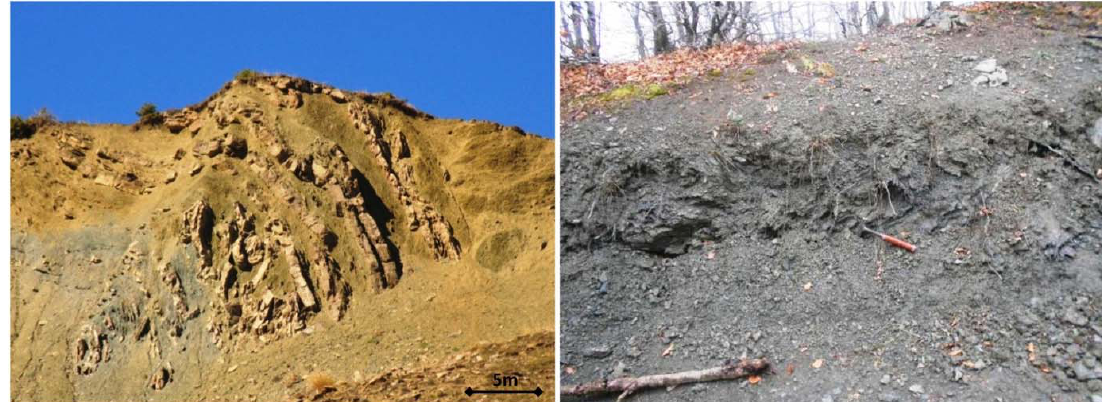
Figure 10. Typical examples of flysch type VIII ( left ) and flysch type IX ( right ) at landslide masses.